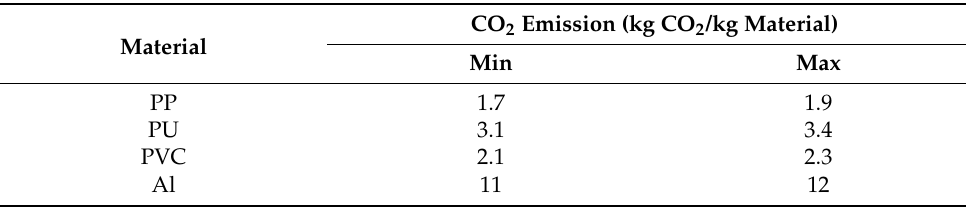
Table 2. CO 2 emissions, expressed in kgCO 2 /kg Material, for each material masks are made obtained by the software Ces Selector.